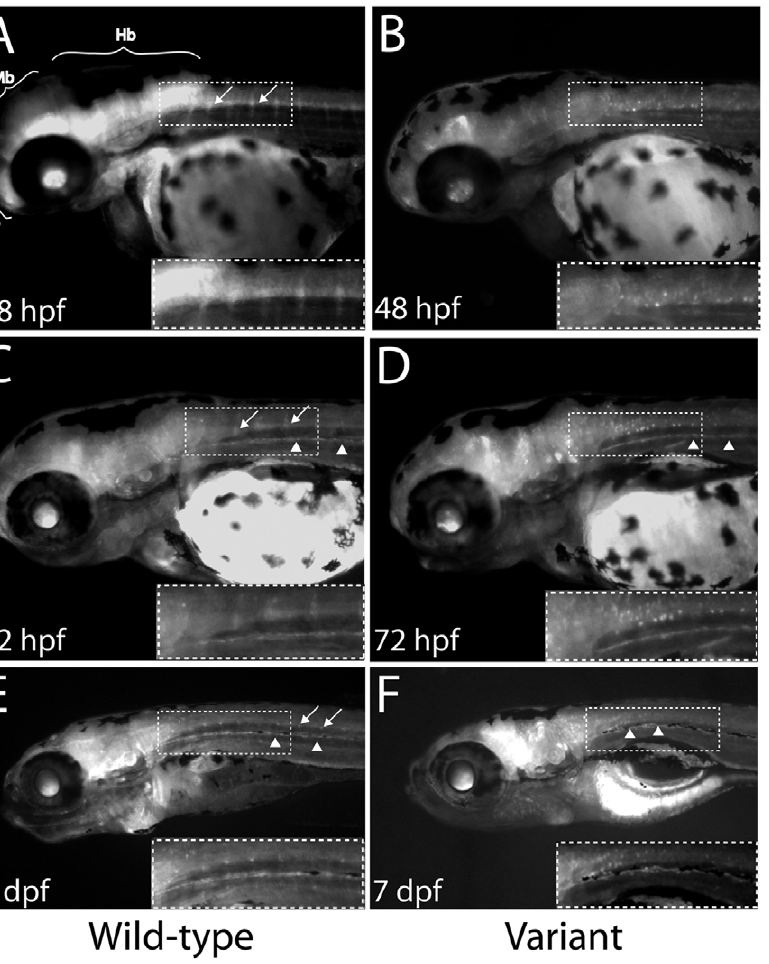
Figure 3. MPZ-MCS3 directs reporter gene expression in relevant tissues invivo . Wild-type ( A , C , and E ) and c.126-1086T . A variant ( B , D , and F ) containing MPZ -MCS3 were studied for their ability to direct the expression of EGFP in developing zebrafish; expression was analyzed at the indicated developmental stages; EGFP expression is noted in structures consistent with the hindbrain (Hb), midbrain (Mb), forebrain (Fb), descending motor neurons (arrows), lateral line (arrow heads), and oligodendrocytes (boxes and inset in F ).